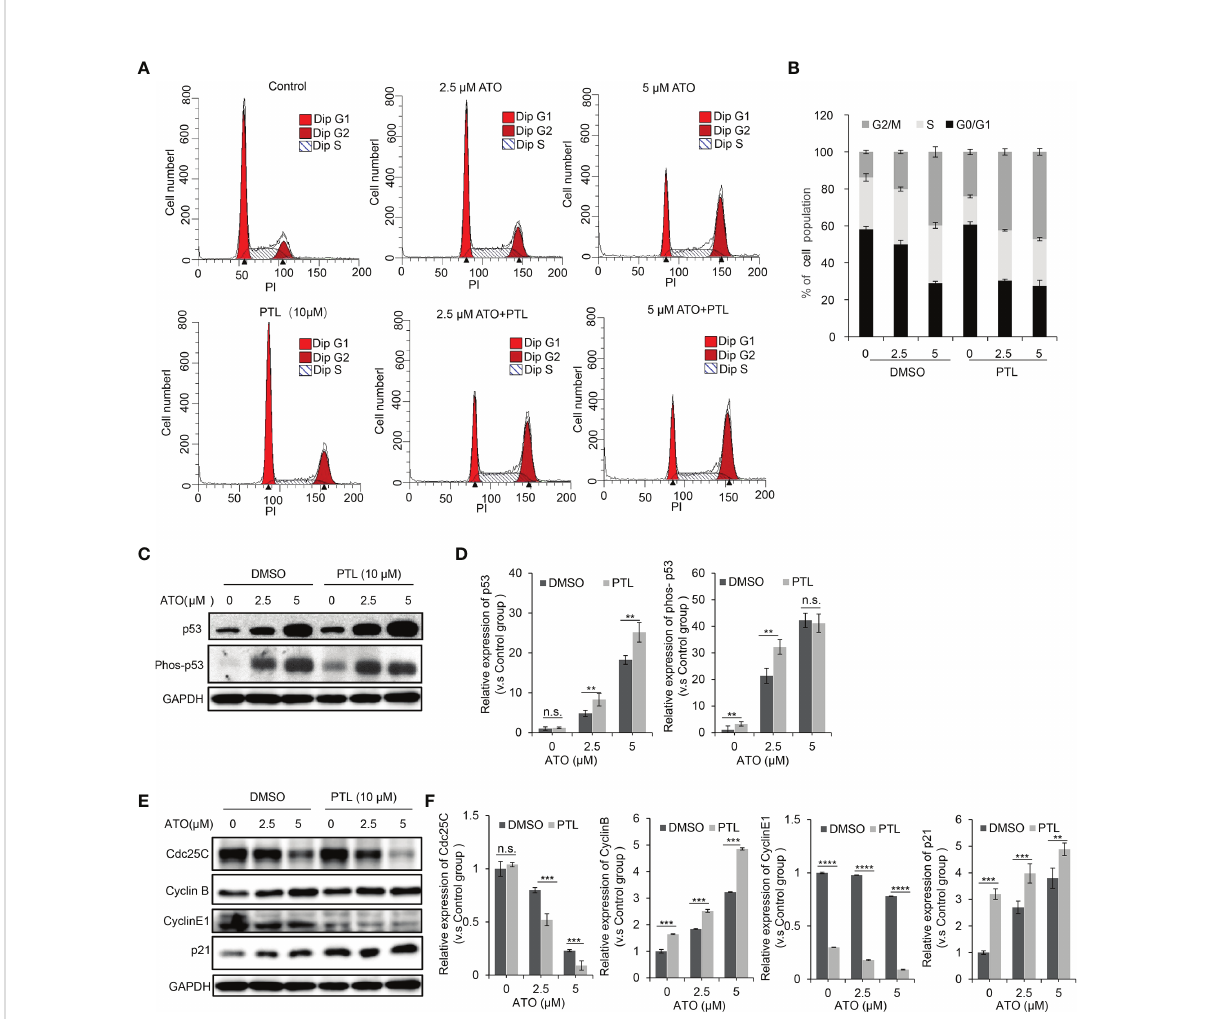
FIGURE 3 PTL worsened blockage of the cell cycle induced by ATO. Exposure to indicated concentrations of ATO, PTL and ATO plus PTL for 24 h. (A) The distribution of cell cycle in HepG2 was measured using Flow cytometry after PI staining. The percentage of G 0 G 1 , S and G 2 M were quanti fi ed as in (B) . (C) HepG2 cells were harvested and analyzed with indicated antibodies, and the expression of proteins were quanti fi ed as in (D) ; Columns, mean; bars, ± S.D. of 3 independent experiments (** P < 0.01; n.s., no signi fi cance). (E) HepG2 cells were harvested and analyzed with indicated antibodies, and the expression of proteins were quanti fi ed as in (F) ; Columns, mean; bars, ± S.D. of 3 independent experiments (**, P < 0.01; *** P < 0.001; **** P < 0.0001; n.s., no signi fi